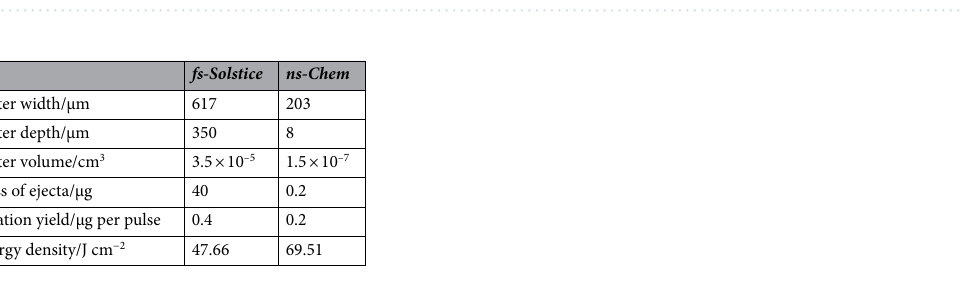
Table 5. Craters and ablation features of fs-Solstice and ns-Chem systems for coal samples